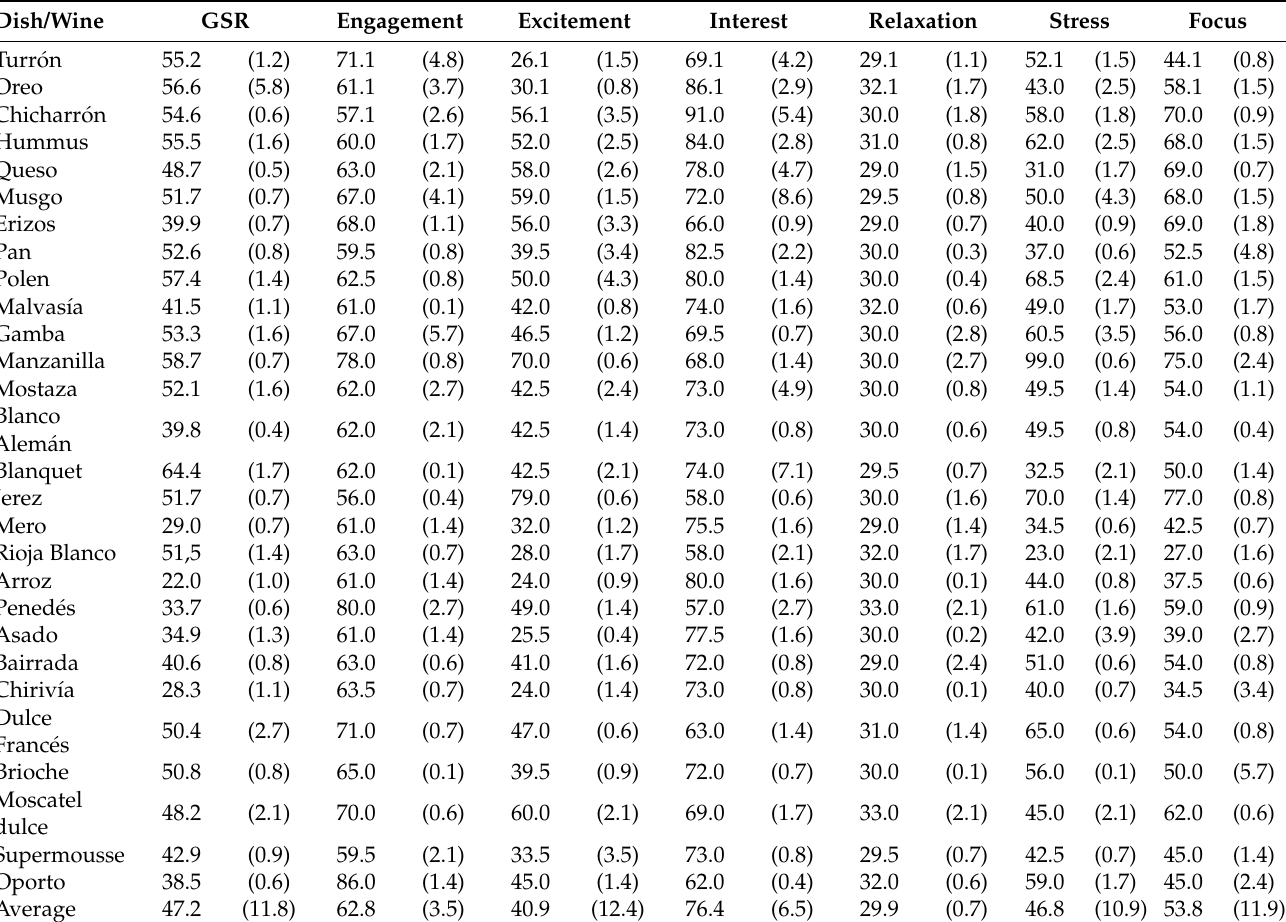
Figure 9. GSR and electroencephalography (EEG) summary analysis of presentation phase and tasting phase for each dish and wine. Source: Original work from the authors. Table 3. GSR and electroencephalography (EEG) activity percentage (standard error). Source: Original work from the